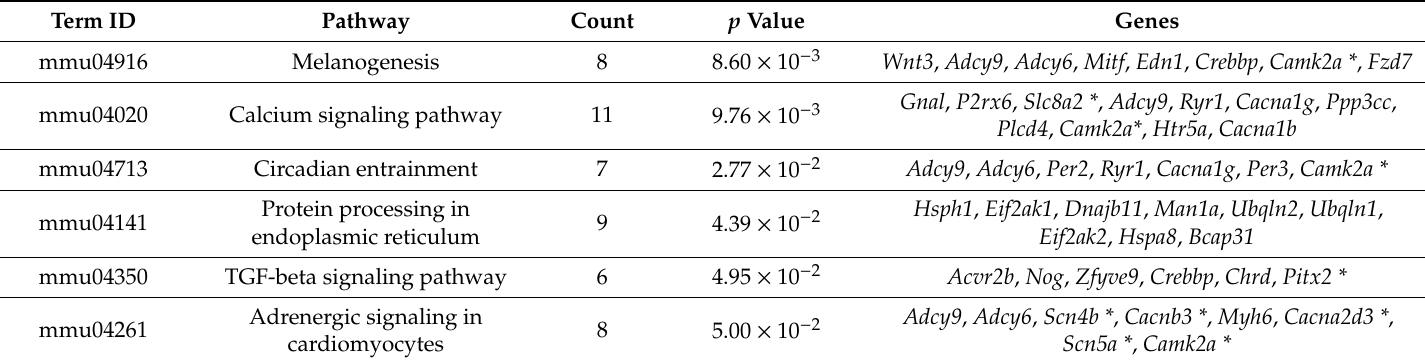
Table 7. Metabolic pathways that include genes that maximize intergroup di ff erences when comparing winners with defeated